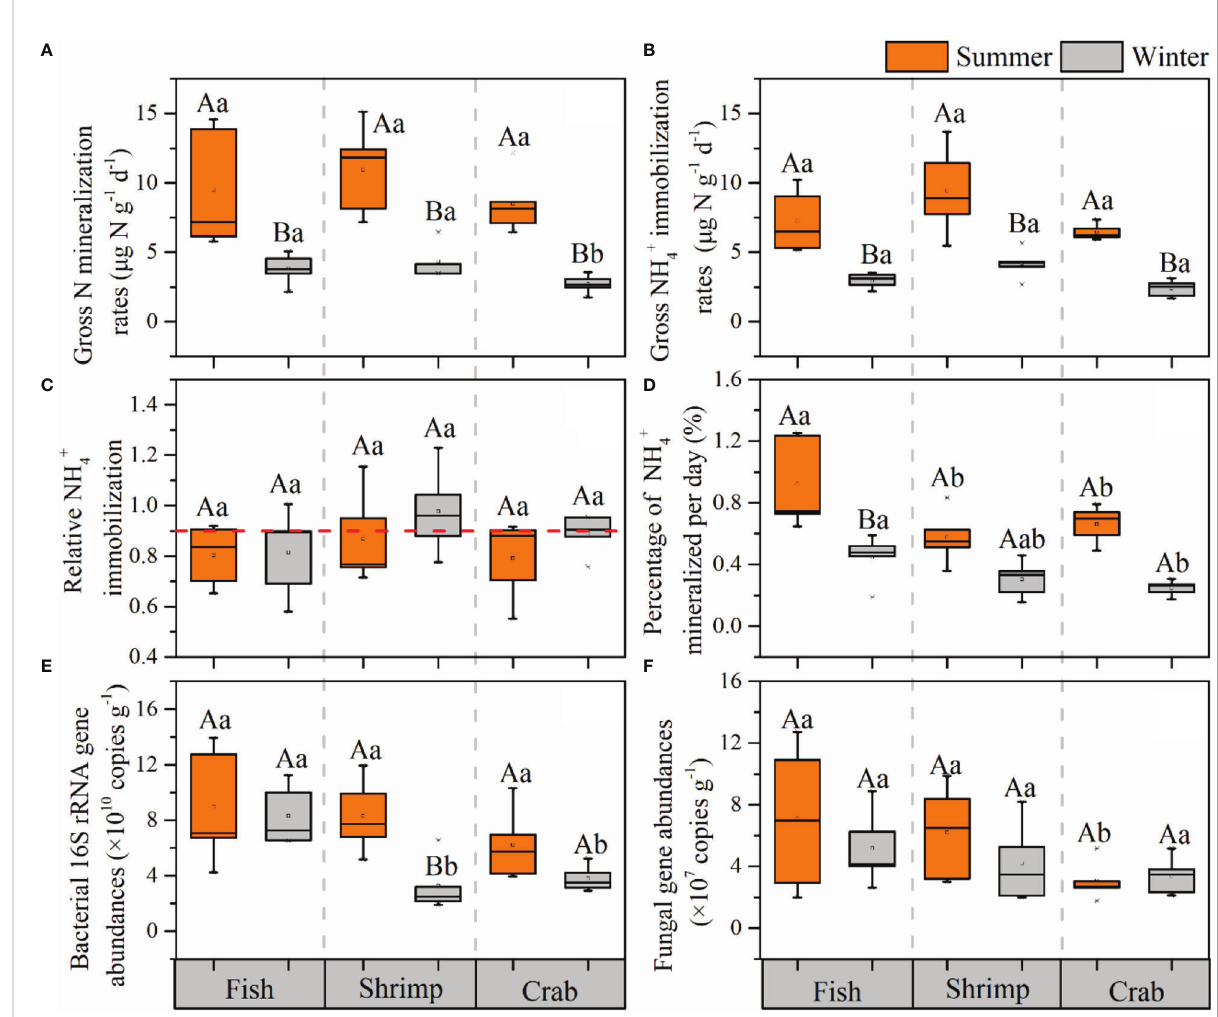
FIGURE 2 Spatiotemporal variations of gross N mineralization rates (A) , gross NH 4+ immobilization rates (B) , relative NH 4+ immobilization (C) , percentage of NH 4+ mineralized per day (D) , and microbial abundances (E, F) in the surface sediments of different reclaimed aquaculture ponds in summer and winter. Statistically signi fi cant difference between seasons is labeled in the different uppercase letters, and the signi fi cant difference between aquaculture ponds is labeled in the different lowercase